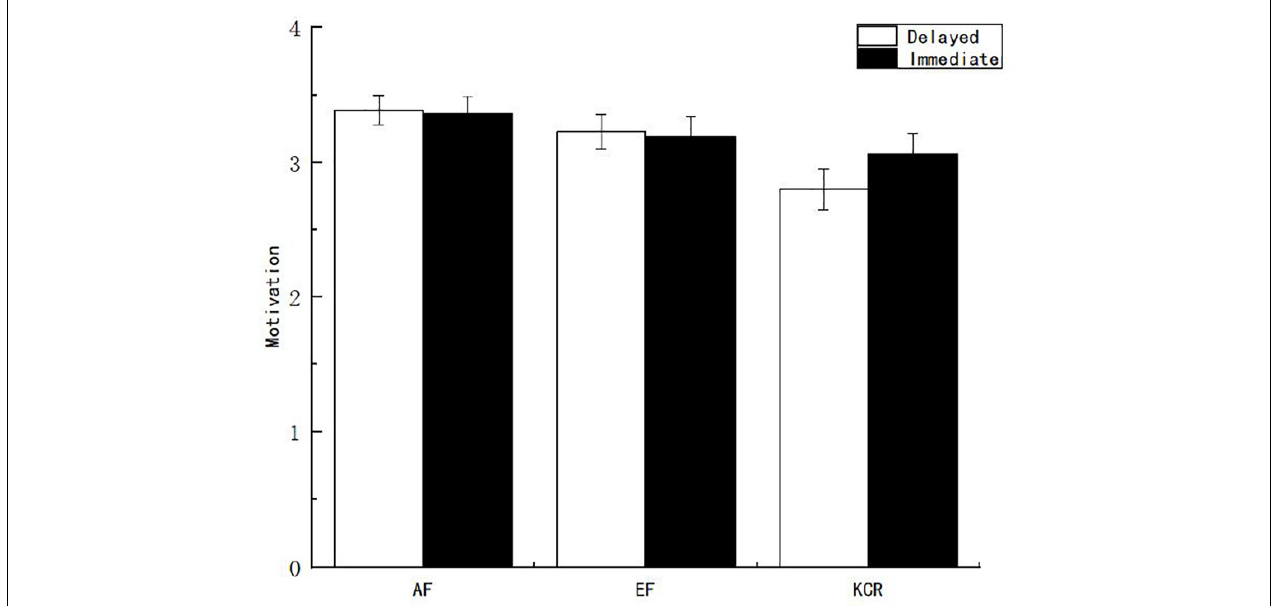
FIGURE 2 | Situational learning motivation of learners under different feedback conditions.